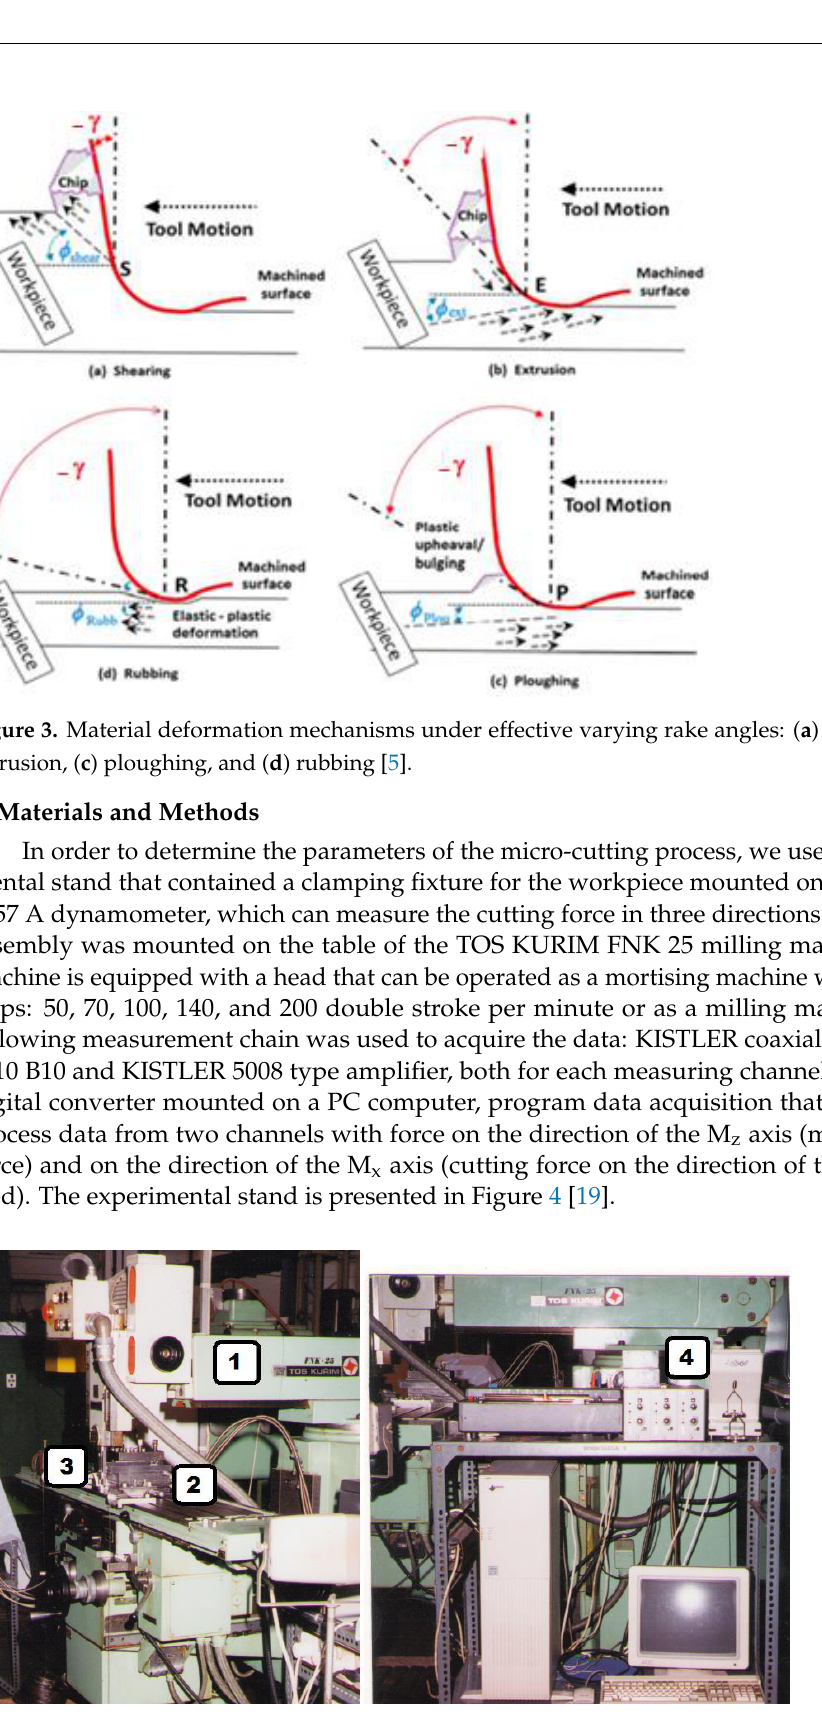
Figure 4. Experimental stand: (1) milling machine TOS KURIM FNK 25; (2) Multicomponent dynamometer KISTLER 9257 A; (3) Cutting tool; and (4) Multichannel charge amplifier Type 5080Axx3x001.